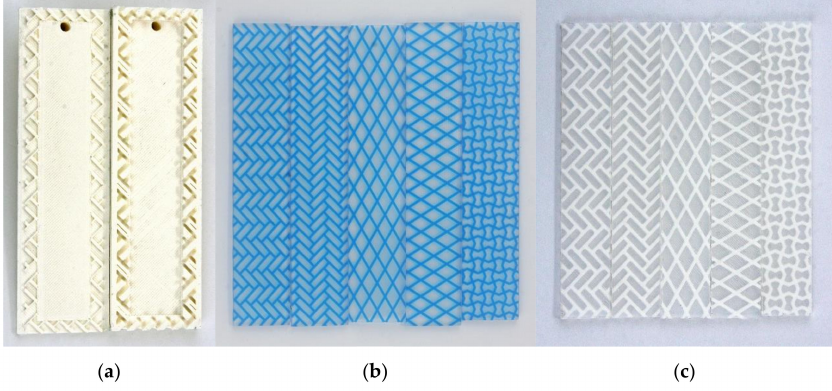
Figure 5. 3D printed specimen mold and pattern-embedded specimens: ( a ) 3D printed specimen mold for Pattern A with major axis alignment; ( b ) 3D printed pattern-embedded specimens; and ( c ) silicon-molded pattern-embedded